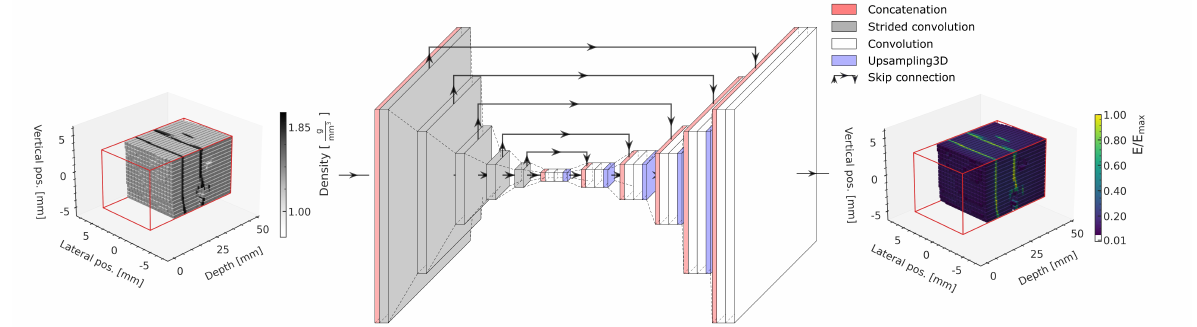
Figure 6. Schematic of the implemented deep learning model predicting energy deposition based on a material matrix input. Adapted from